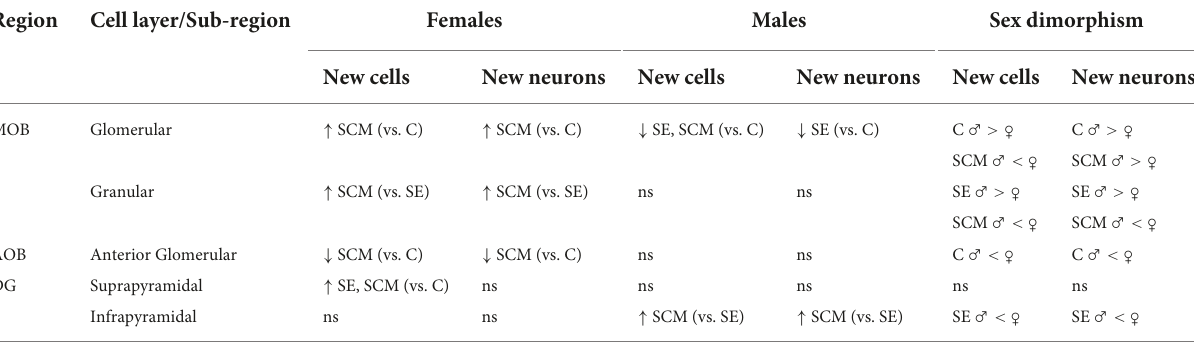
Summaryoftheprincipalfindingsincellsurvivalincontrol(C),socialexposure(SE),socialcohabitationwithmating(SCM)groupsinthemainolfactorybulb(MOB),accessoryolfactory bulb (AOB), and dentate gyrus (DG) of the hippocampus. ↑ Increases, ↓ decreases; < or > represent significant differences p < 0.05; ns, no statistic differences were